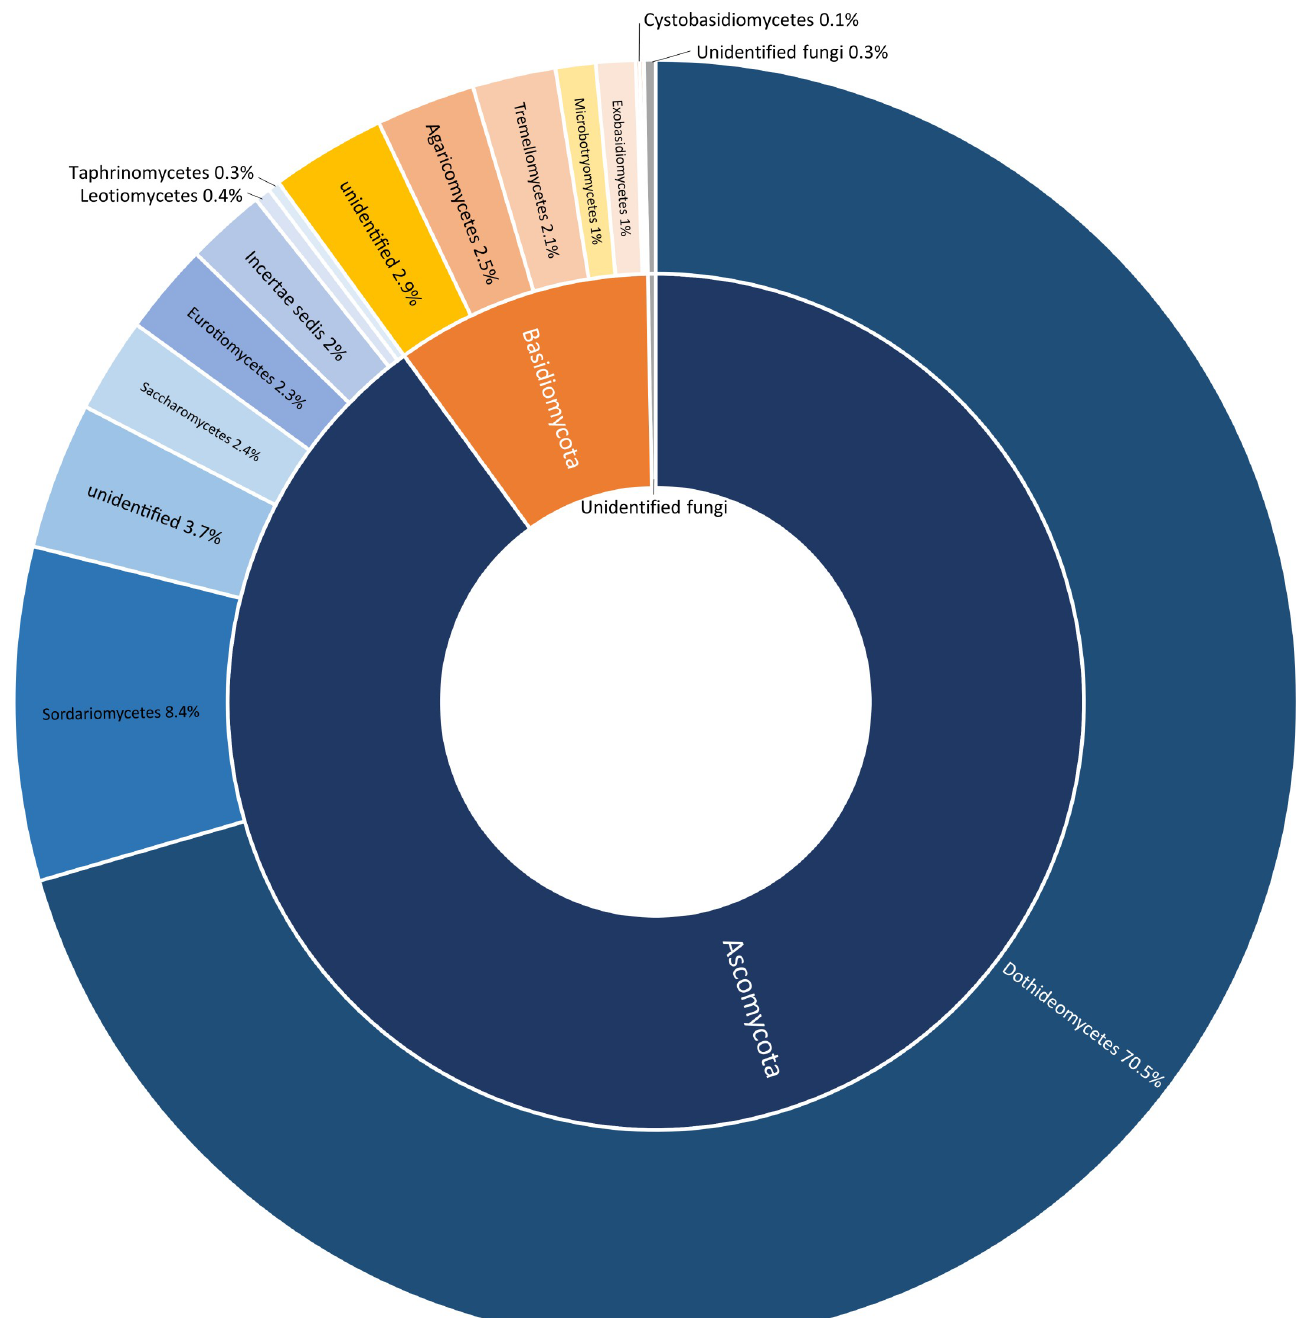
Fig 1. Sunburst chart showing the total relative abundance of fungal phyla (interior circle) and classes (exterior circle) overall detected in infested and non- infested olives in the four investigated localities.